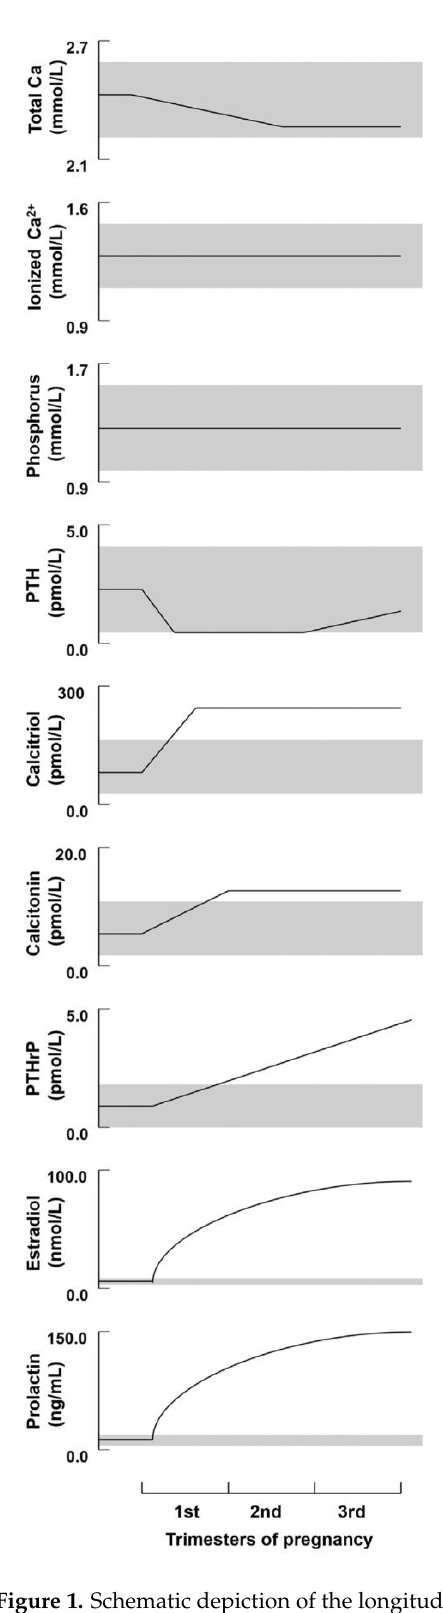
Figure 1. Schematic depiction of the longitudinal changes in calcium, phosphorus, and calciotropic hormone levels during human pregnancy. Shaded regions depict the approximate normal ranges (reproduced with permission form Kovacs, C.S. et al.; Physiol. Rev. ; 2016